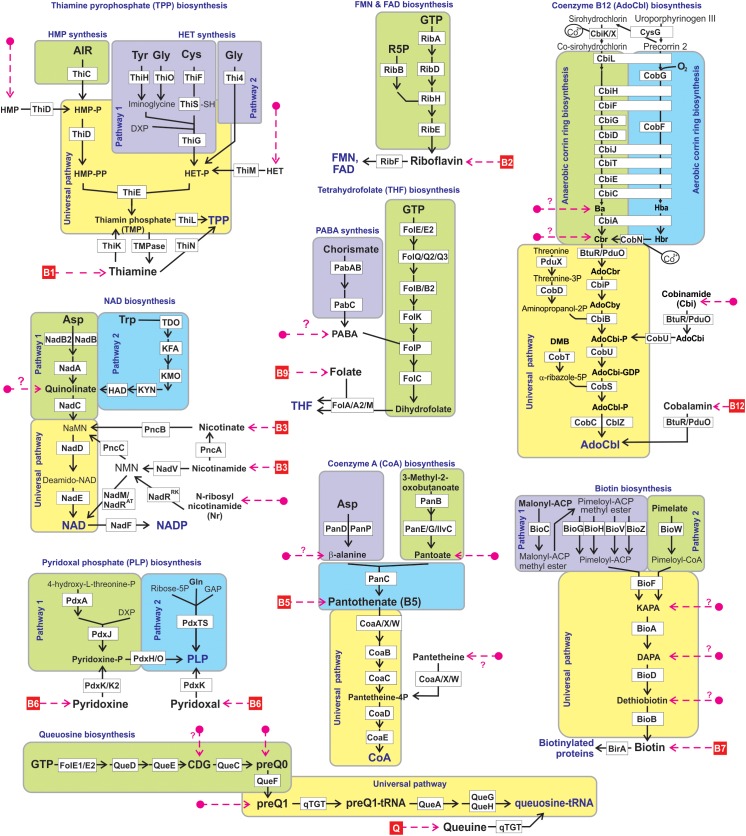
Reconstructed vitamin/cofactor biosynthesis and salvage pathways in HGM genomes. Eight B-vitamins, and queuine (Q) are shown in red boxes. Alternative and universal biosynthetic pathways are marked in blue text and highlighted in colored blocks. Biosynthetic reactions and vitamin/vitamer uptake are depicted by solid black and red dashed lines, respectively. Enzymes are shown by white boxes. The detailed information of enzyme commission (EC) numbers, functional annotations, metabolite abbreviations, and transporter names are provided in Supplementary Figure S1.